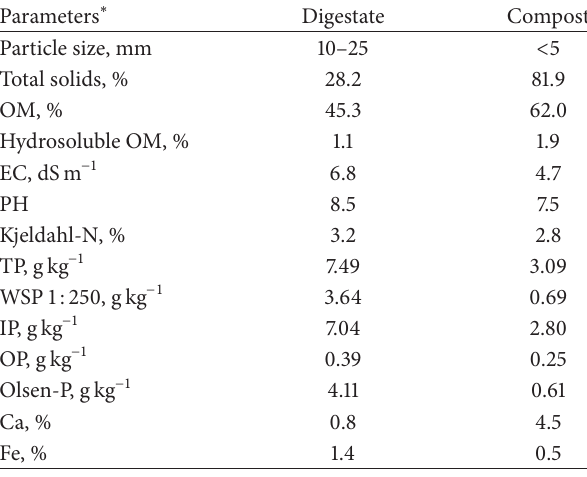
−3 10 to 6.7 10 1.8 10 −3 h −1